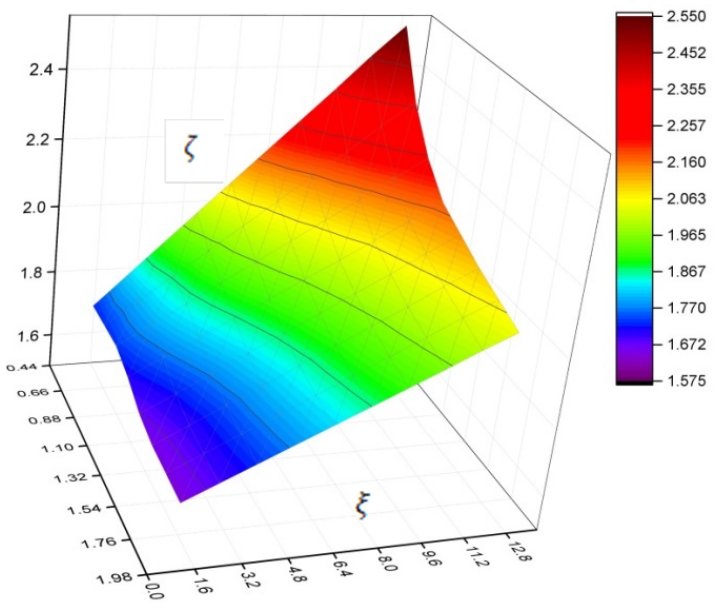
Figure 20. The interpolation polynomial surface from Equation (5) stress concentration factor.